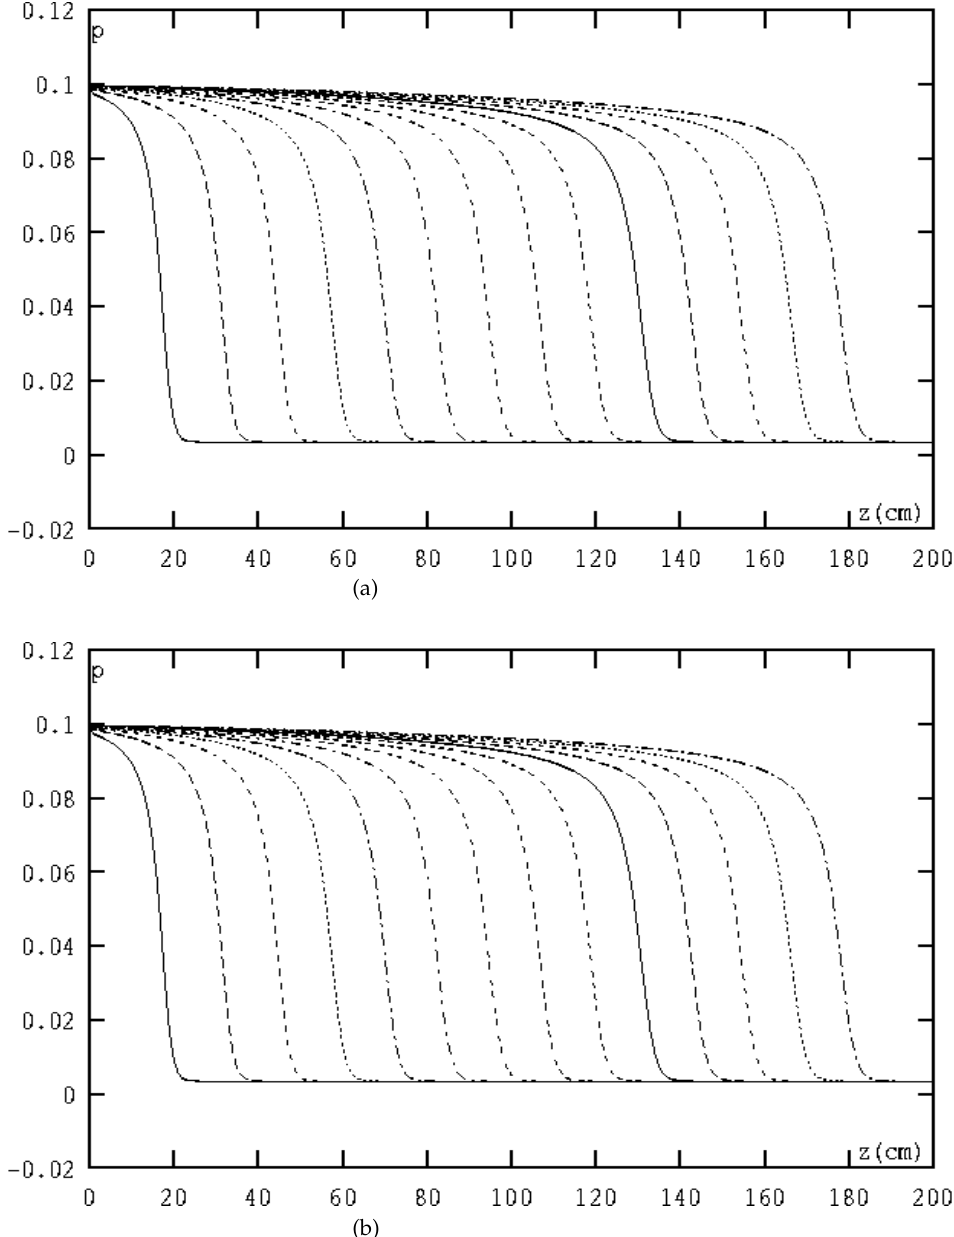
Figure 2. ( a ) The curves are the PPMFERD solution of infiltration water flux at t = 60 h, 120 h, . . . , 420 h, respectively. ( b ) The curves are the MFE solution of infiltration water flux at t = 60 h, 120 h, and . . . , 420 h,